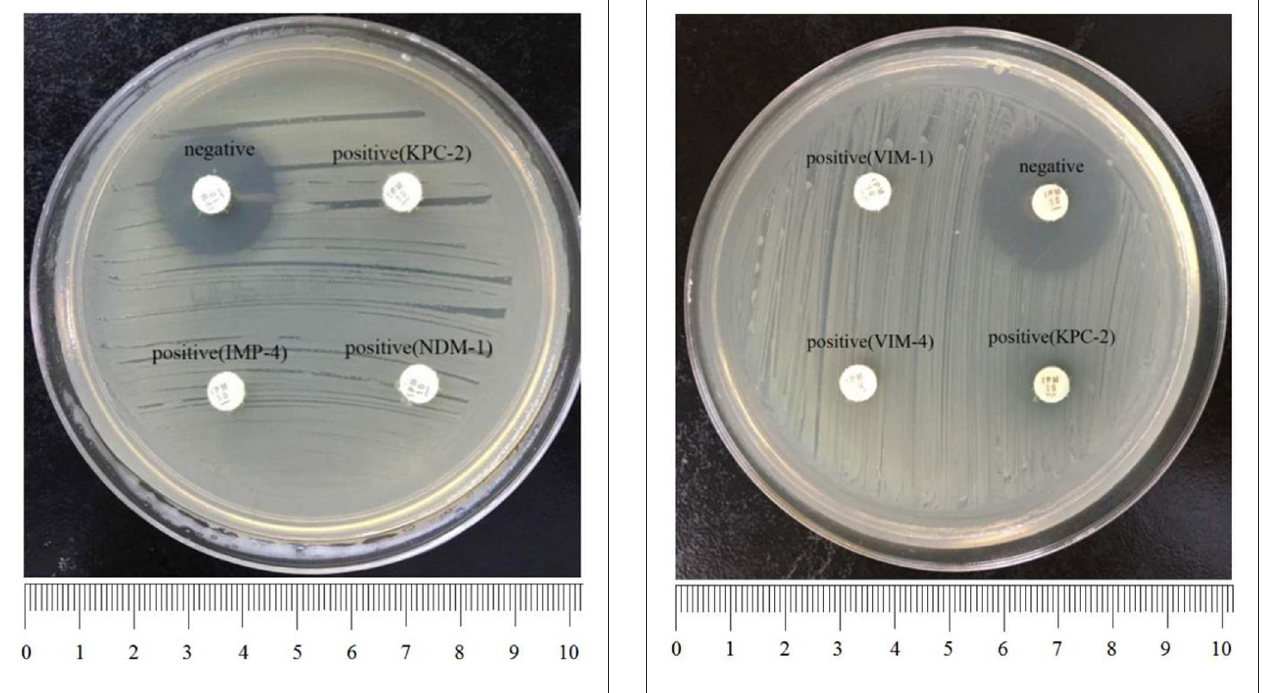
FIGURE 1 | Results of rCDM testing of Enterobacteriaceae (6h). The zone of inhibition of the negative isolate was 22mm, whereas the zone of inhibition of the positive isolates was 6mm. Upper right, KPC-2-producing K. pneumoniae ; bottom left, IMP-4-producing E. coli ; bottom right, NDM-1-producing E. cloacae .